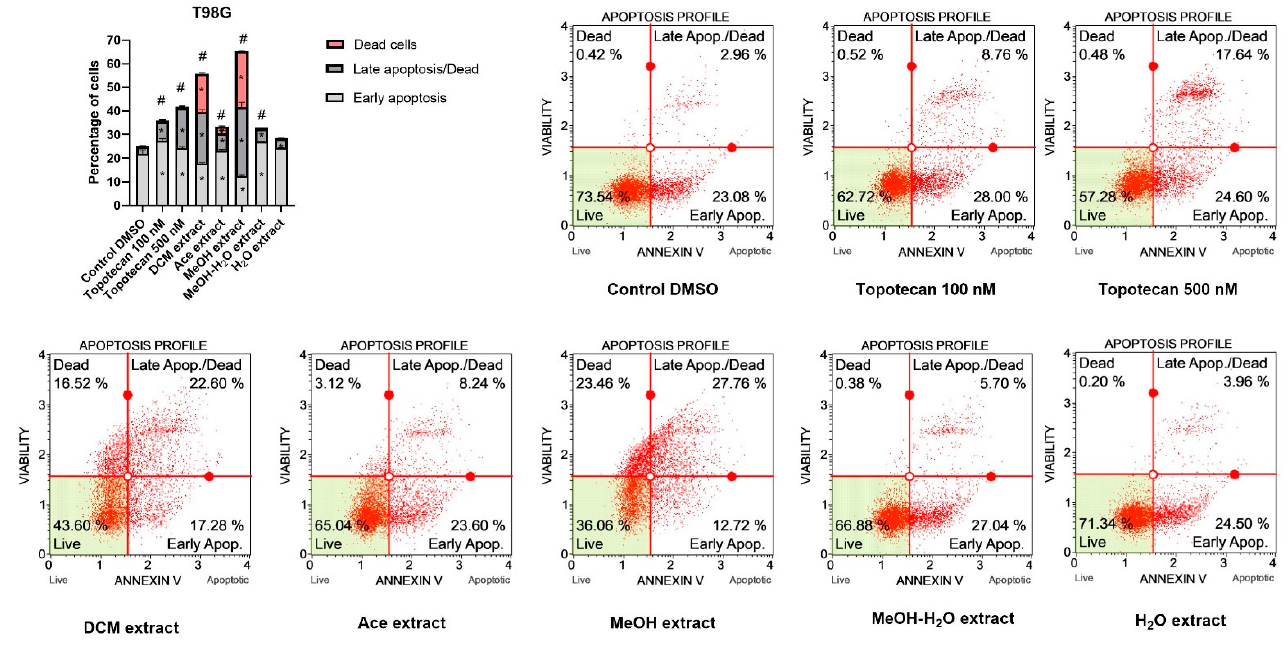
Figure 7. Apoptosis profiles of T98G cells as studied by the Muse™ Annexin V & Dead Cell Kit after 48 h of treatment. Values on the bar chart are shown as mean ± SEM calculated from two independent experiments. (*) indicates statistically significant differences from control group for dead, late apoptosis/dead or early apoptosis cells; (#) above bar indicates statistically significant differences from control group for total apoptotic/dead cells, p < 0.05. Representative histograms of controls (DMSO—negative control, topotecan—positive control) and analysed P. glauca extracts are also presented. Each histogram has four quadrant markers, reflecting the different cellular states: the upper left quadrant contains dead cells (necrosis), the upper right has late apoptotic/dead cells (cells that are positive both for Annexin V and for 7-Aminoactinomycin D), the lower left contains live cells and the lower right early apoptotic cells (cells that are positive only for Annexin